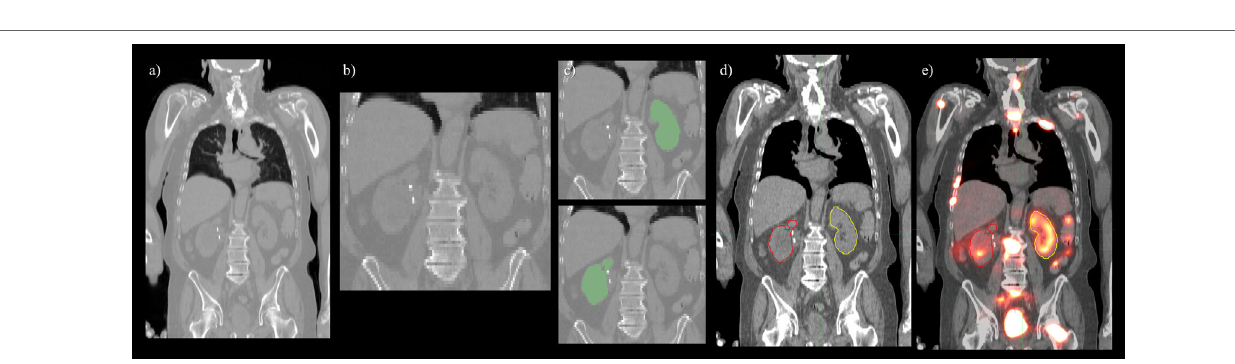
FigUre 2 | Pre­ and post­processing workflow developed for automated renal dosimetry. Input image (a) is automatically cropped to a smaller search area based on alignment to a reference image volume. The cropped and downsampled image (B) , 128 × 128 × 64 voxels, is used as input to the convolutional neural networks segmentation model. Labeled left and right kidneys (c) are then upsampled, smoothed, and fused with the original, uncropped image (D) . Label map is exported in dicom­RT structure file, where voxel dose images may be analyzed on a hospital workstation (e) .